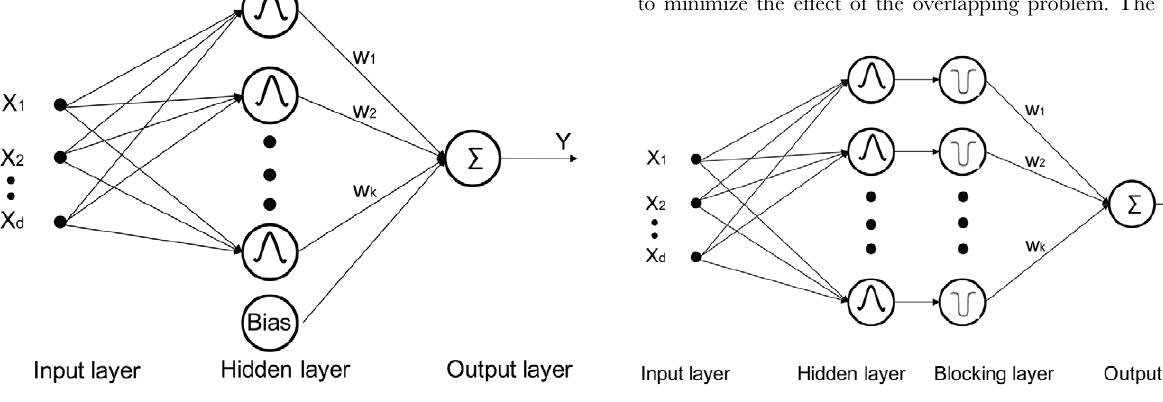
Figure 4. MSRBF architecture.